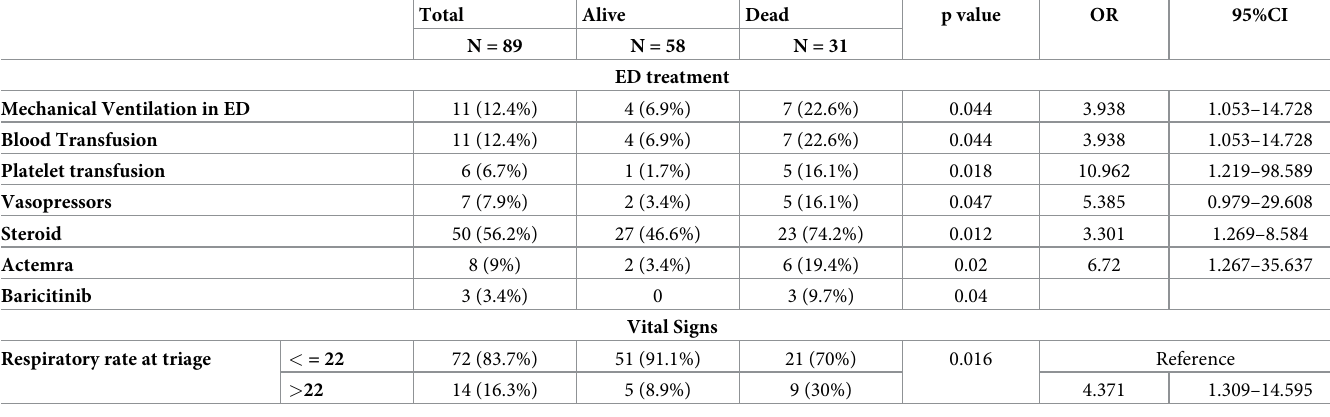
Data are presented as numbers with percentages.